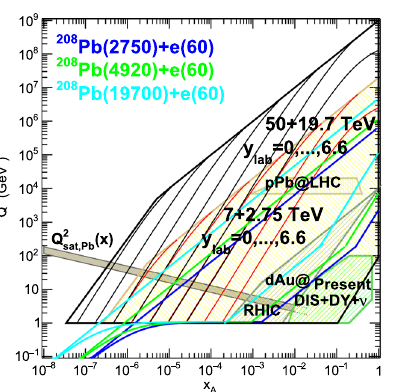
to different rapidities in the laboratory frame y lab = 0 , 1 , 2 , 3 , 4 , 5 , 6 from right to left, with the left edge defined by y lab = 6 . 6. Values of ( x ) for Pb are shown for Q 2 S